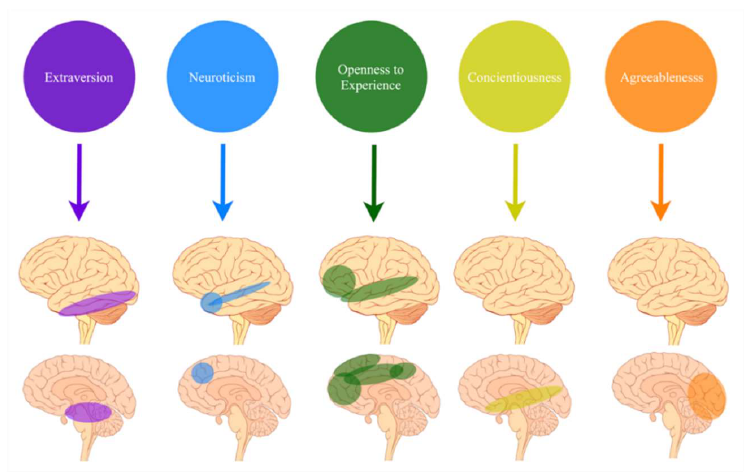
Figure 1. Schematic demonstration of the top down approach to personality study. Arrows in this figure represent the direction by which lower level concepts, in this case brain connectivity [21], are defined through use of the higher-level concepts of the FFM trait measure. The direction of this definition means that brain regions and/or connectivity are dependent upon the higher-level concept of the personality trait .